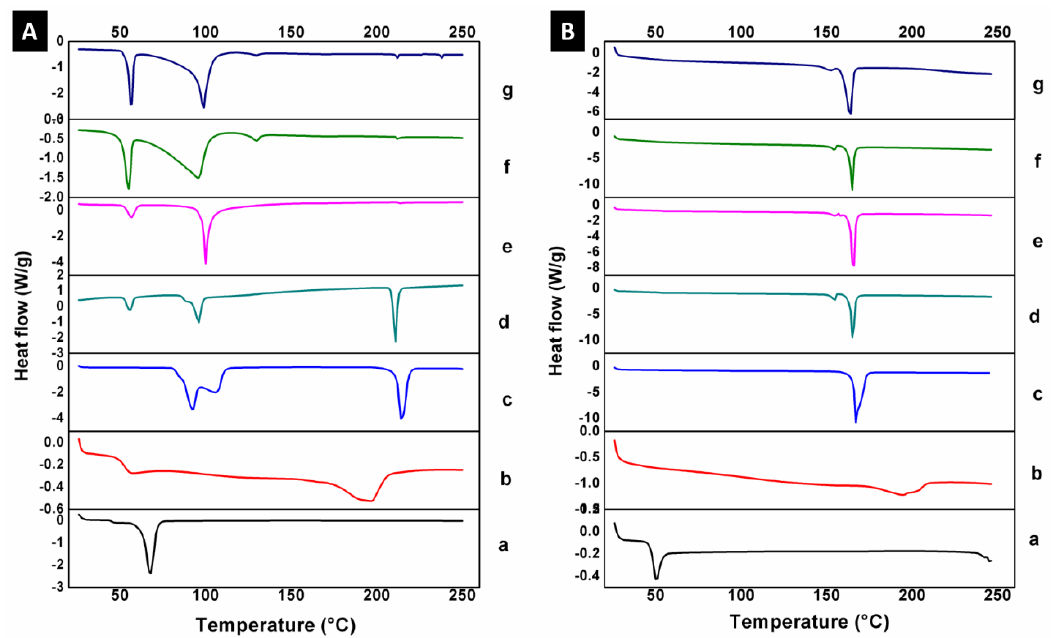
Figure 4. Di ff erential scanning calorimetry of nanoparticles. ( A ) Thermogram of the PCL / PVA NP system; (a) PCL, (b) PVA, (c) trehalose, (d) non-sterilized PCL / PVA NP, (e) PCL / PVA NP after UV Figure 4. Differential scanning calorimetry of nanoparticles. ( A ) Thermogram of the PCL/PVA NP radiation, (f) PCL / PVA NP after 5 kGy of gamma radiation, and (g) PCL / PVA NP after 10 kGy of system; (a) PCL, (b) PVA, (c) trehalose, (d) non-sterilized PCL/PVA NP, (e) PCL/PVA NP after UV gamma radiation. ( B ) Thermogram of the PLGA / PVA NP system; (a) PLGA, (b) PVA, (c) mannitol, radiation, (f) PCL/PVA NP after 5 kGy of gamma radiation, and (g) PCL/PVA NP after 10 kGy of (d) non-sterilized PLGA / PVA NP, (e) PLGA / PVA NP after UV radiation, (f) PLGA / PVA NP after 5 kGy gamma radiation. ( B ) Thermogram of the PLGA/PVA NP system; (a) PLGA, (b) PVA, (c) mannitol, of gamma radiation, and (g) PLGA / PVA NP after 10 kGy of gamma (d) non-sterilized PLGA/PVA NP, (e) PLGA/PVA NP after UV radiation, (f) PLGA/PVA NP after 5 kGy of gamma radiation, and (g) PLGA/PVA NP after 10 kGy of gamma radiation. Table 2. Main thermal events of the excipients and NP before and after sterilization by UV and gamma radiation recorded by differential scanning calorimetry.